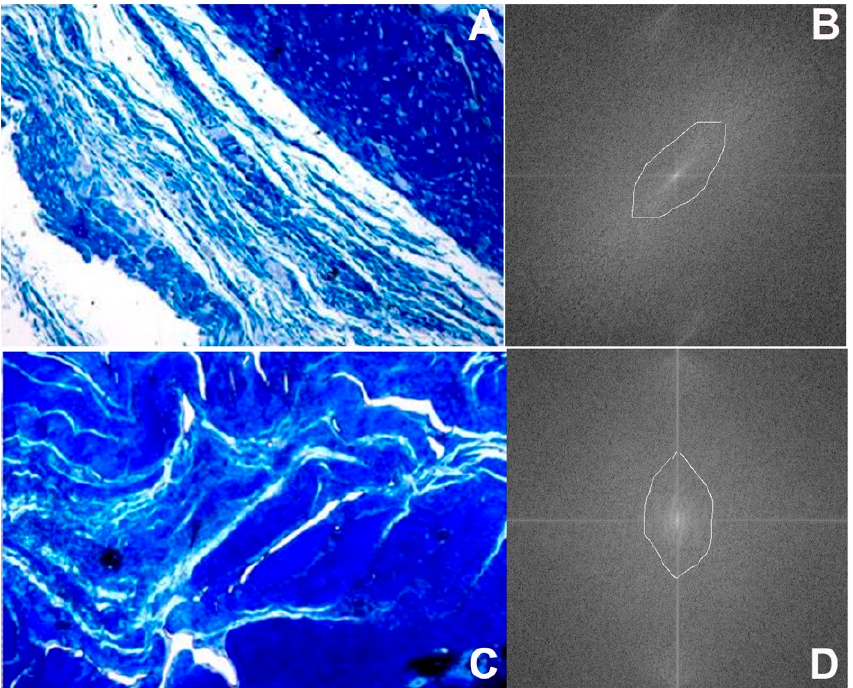
Figure 5. Measurement of collagen bundle orientation by Fourier analysis. Histological micropho- tographs were processed with a best fit filter ( A , C ). The fast Fourier transform was obtained, and the maximum length and width of the central structure was automatically calculated to obtain the collagen orientation index of the picture ( B , D ), with a collagen orientation index of 0.88 for the non-treated group ( D ) and a collagen orientation index of 0.5 for the Hyaloglide group ( B ).